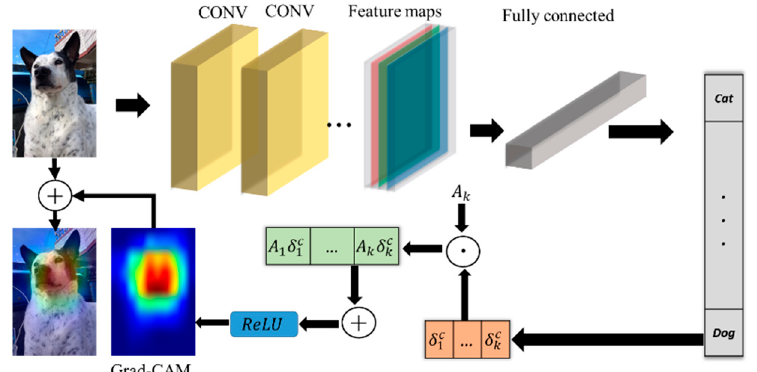
Figure 3. Grad-CAM architecture.